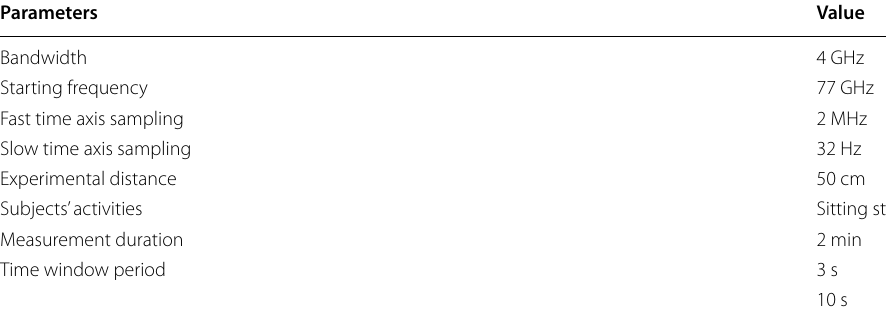
Table 1 Experimental parameters